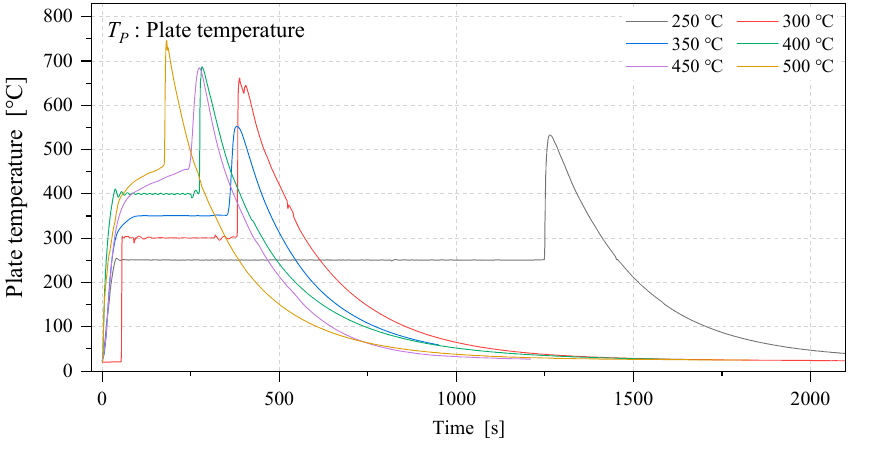
Figure 2. Thermal runaway characteristics of lithium-ion batteries with variations in plate temperature. Table 1. Changes in the state of lithium-ion cell over time under various thermal abuse conditions. Time